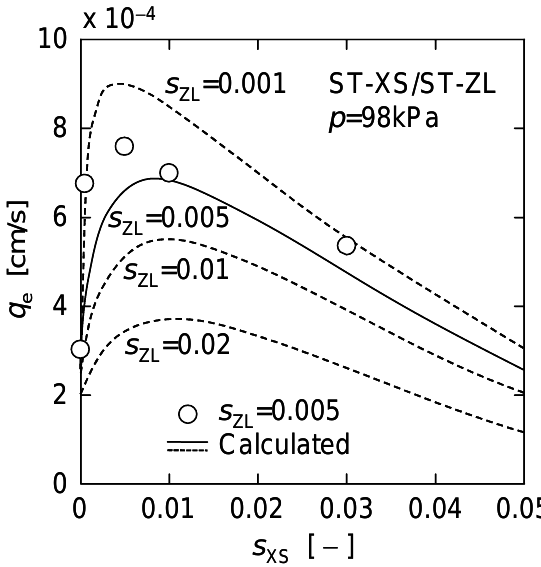
Figure 10. Effect of small particle concentration on steady filtration